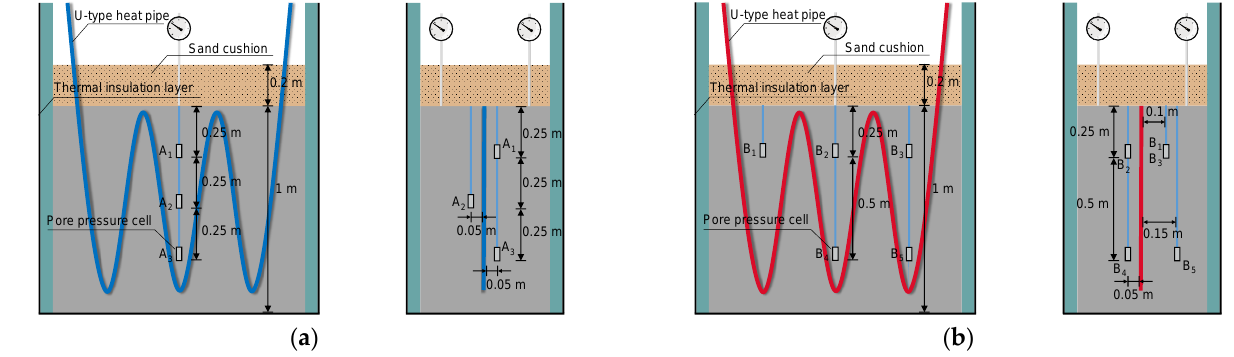
Figure 6. Location of pore water pressure gauge. ( a ) Ambient temperature group; ( b ) solar heating group.